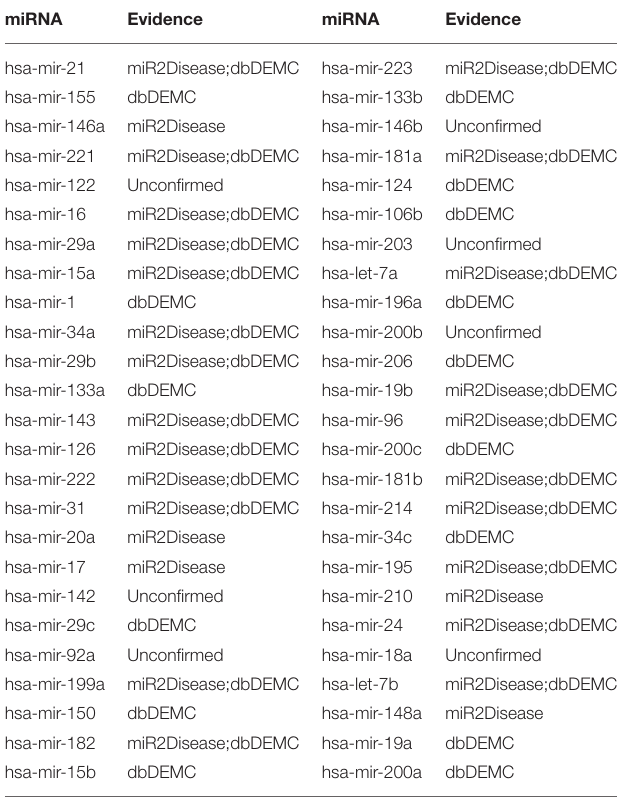
TABLE 1 | The top 50 predicted miRNAs associated with Prostate